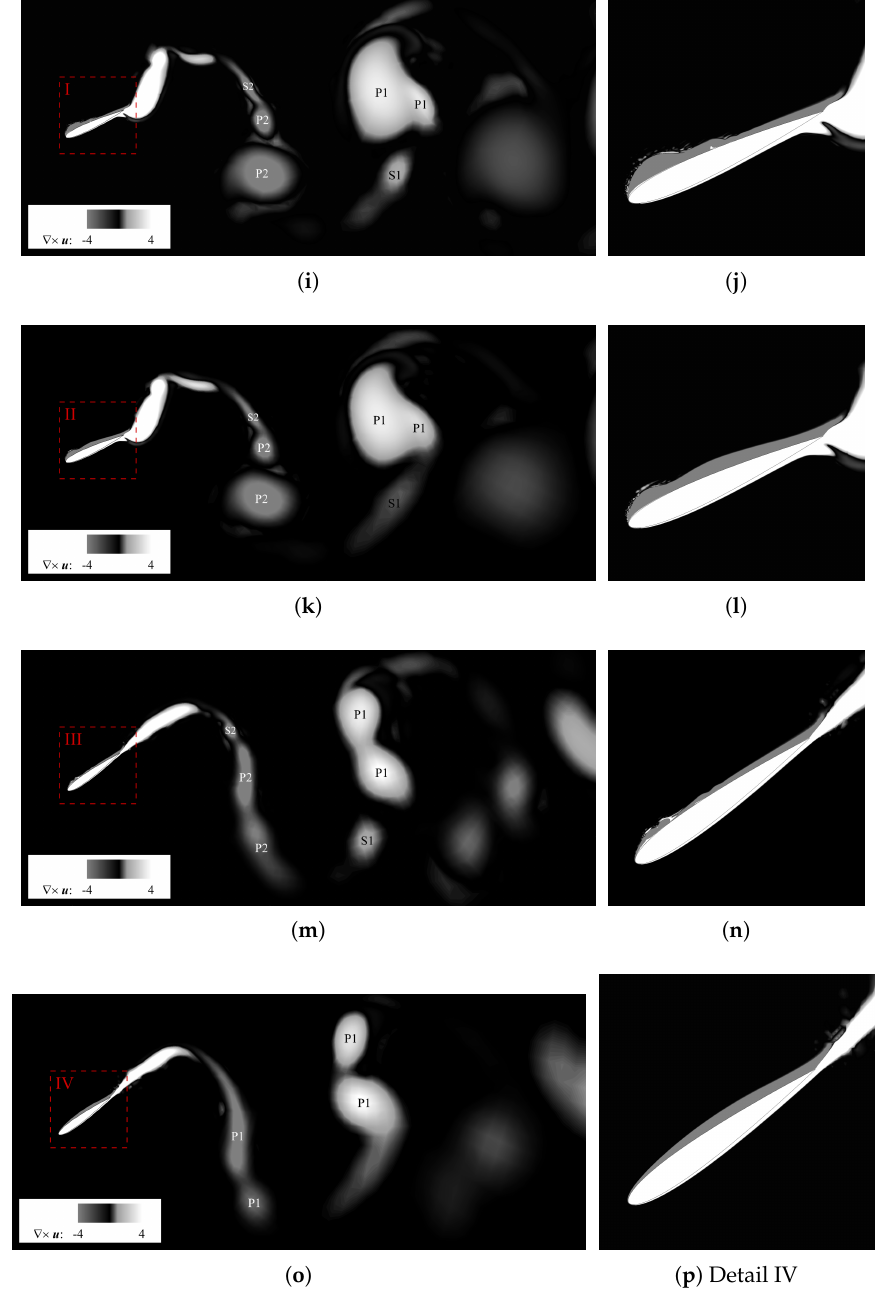
Figure 6. Contour plot of the instantaneous vorticity field using transition and fully turbulent model for St = 0.45. All snapshots are taken at Φ = 0.25. ( a ) α max = 30 ◦ , SA-BCM; ( b ) Detail I; ( c ) α max = 30 ◦ , SA; ( d ) Detail II; ( e ) α max = 20 ◦ , SA-BCM; ( f ) Detail III; ( g ) α max = 20 ◦ , SA; ( h ) Detail